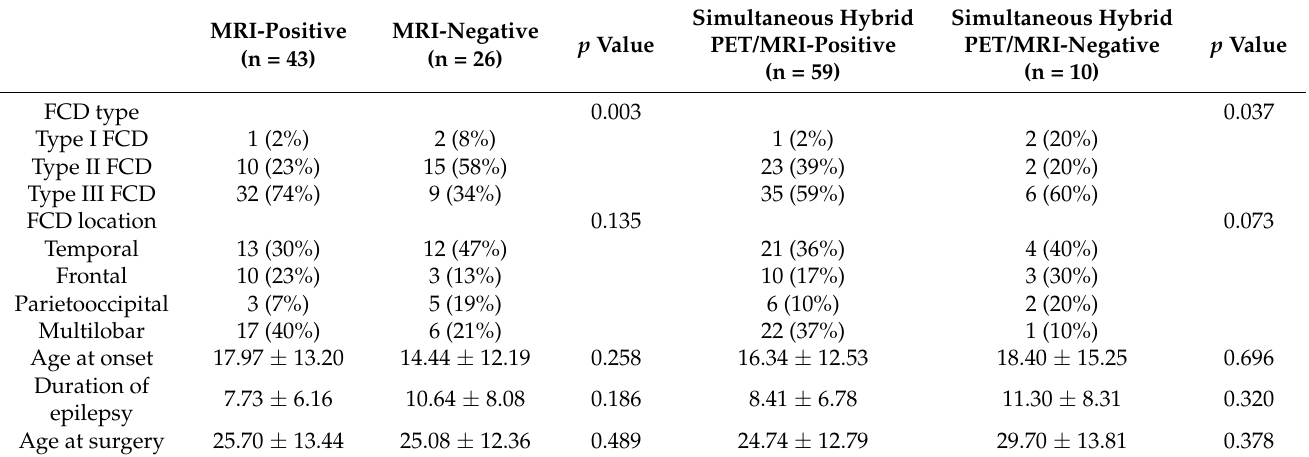
Table 3. Comparison of MRI-positive, MRI-negative, Simultaneous Hybrid PET/MRI-positive, and Simultaneous Hybrid PET/MRI-negative